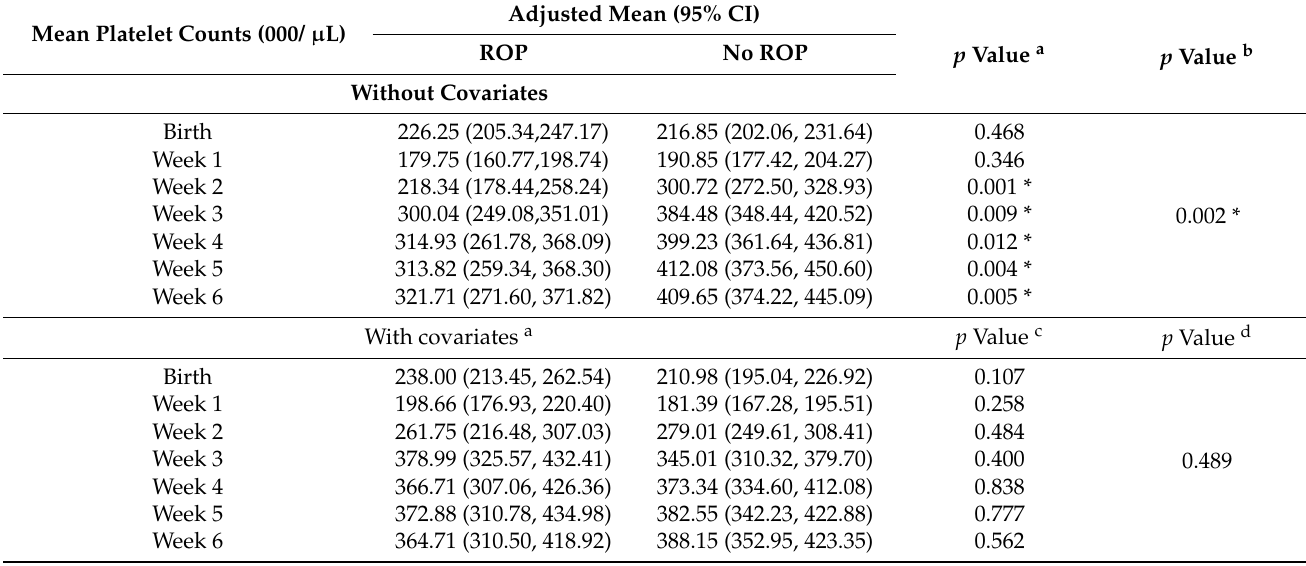
Table 3. Comparison of mean platelet counts between infants with and without ROP based on time.